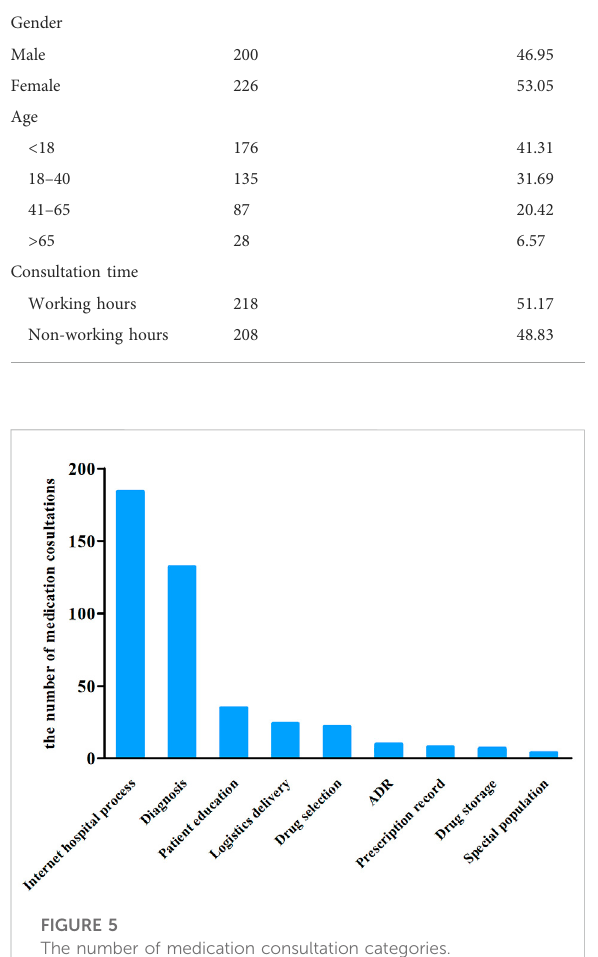
FIGURE 5 The number of medication consultation categories.